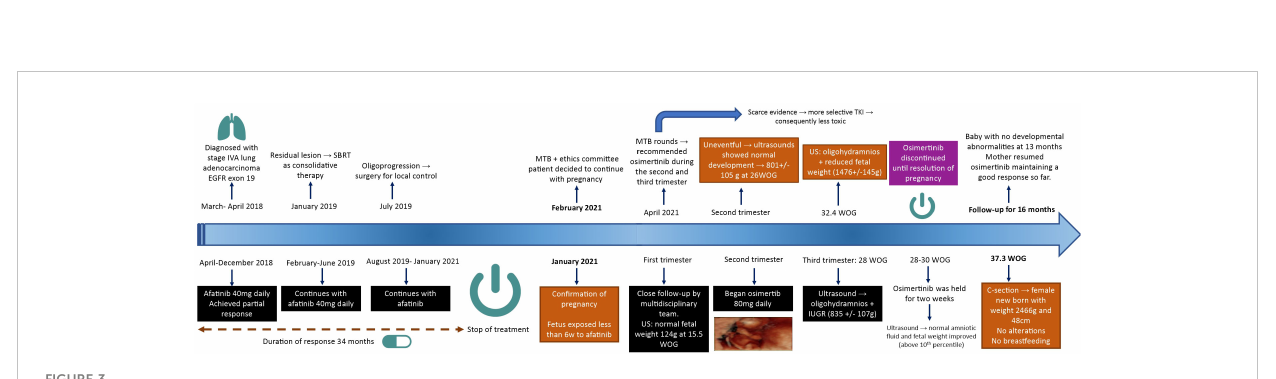
FIGURE 3 Timeline of clinical events from diagnosis to last follow-up